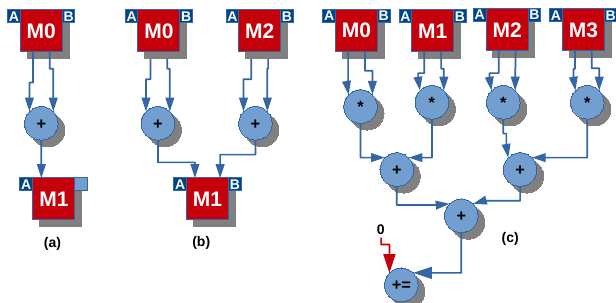
Figure 4. Examples of data engine datapaths. ( a ) Pipelined vector addition with source vector stored in a single memory; ( b ) pipelined vector addition with source vector stored in two memories; ( c ) pipelined implementation of the inner product of two vectors.